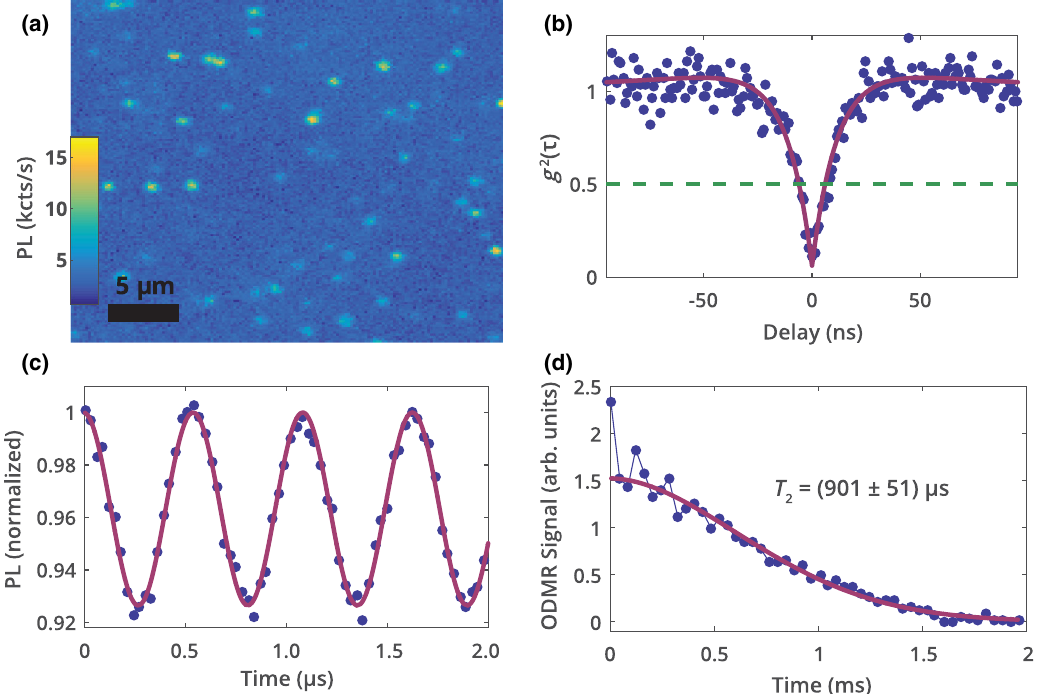
FIG. 1. Isolation and control of single spins in 3C-SiC. (a) A typical two-dimensional photoluminescence scan showing single defects as isolated luminescent spots in 3C-SiC. (b) Photon antibunching observed in the background-corrected photon correlation measurement taken on an isolated photoluminescence spot. The green dashed line indicates the 0.5 threshold below which the Þ at the 95% probability level, emission is consistent with a single quantum emitter. Our analysis indicates g 2 ð τ ¼ 0 Þ ¼ ð 0 . 055 þ 0 . 044 − 0 . 047 which confirms we have isolated a single defect. (c) A measurement of Rabi oscillations recorded on the same defect, which shows an approximate off-resonant readout contrast of 7.5%. (d) Hahn-echo measurement performed on an ensemble of Ky5/L3 defects in the higher-irradiation 3C-SiC sample ( 1 × 10 15 cm − 2 fluence) at T ¼ 20 K and B ¼ 253 G, showing T 2 ¼ ð 901 (cid:3) 51 Þ μ